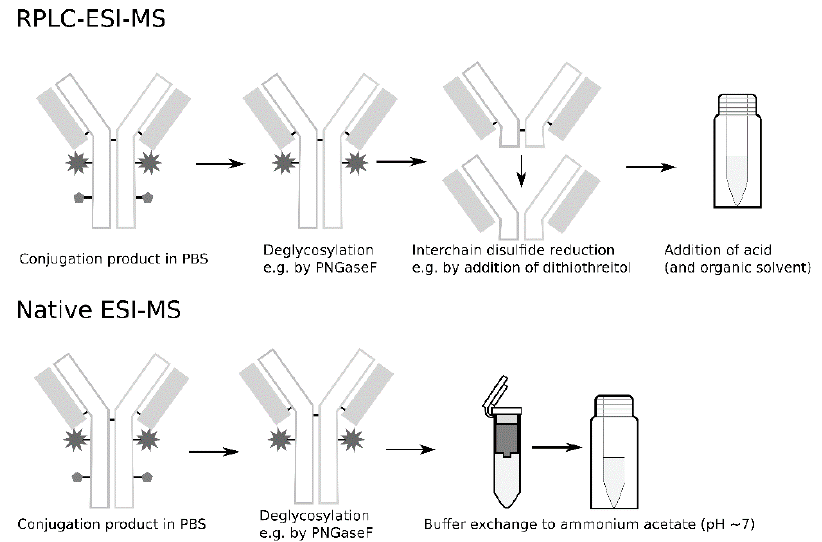
Figure 1. Generic workflows of sample treatment for denaturing and native electrospray ionization mass spectrometry (ESI–MS) protocols used for characterizations of monoclonal antibodies (mAbs) and drug-to-antibody ratio (DAR) determination of antibody–drug conjugates (ADCs).